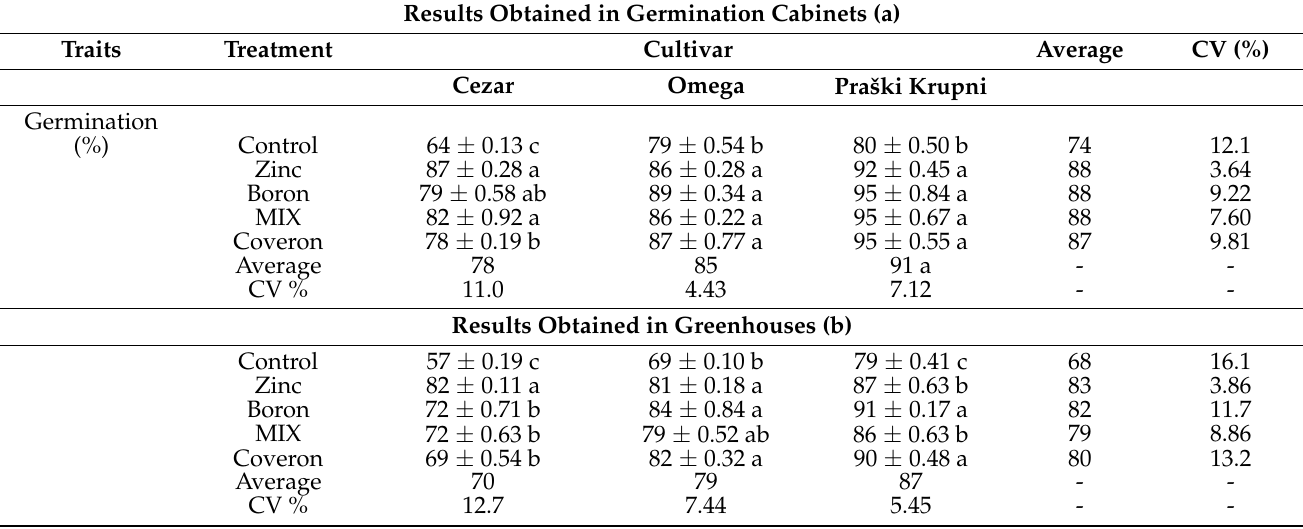
Table 5. Germination after treatments applied to celeriac